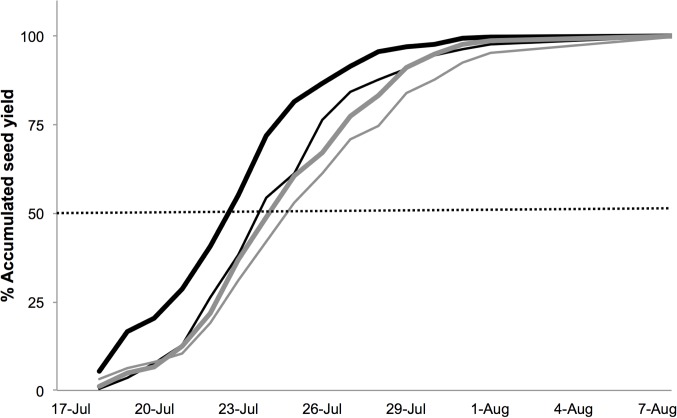
Percentage of accumulated seed yield produced per plant through the flowering season in 2002 in female (black lines) and hermaphrodites (grey lines) Geranium sylvaticum plants in control (thick lines) and shaded conditions (thin lines).The dashed horizontal line indicates 50% accumulated seed production.